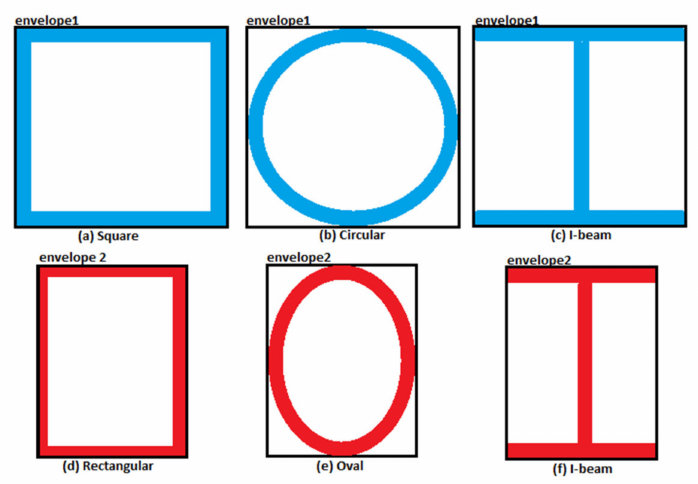
Figure 2. Beam cross sections used to fill the square and rectangular